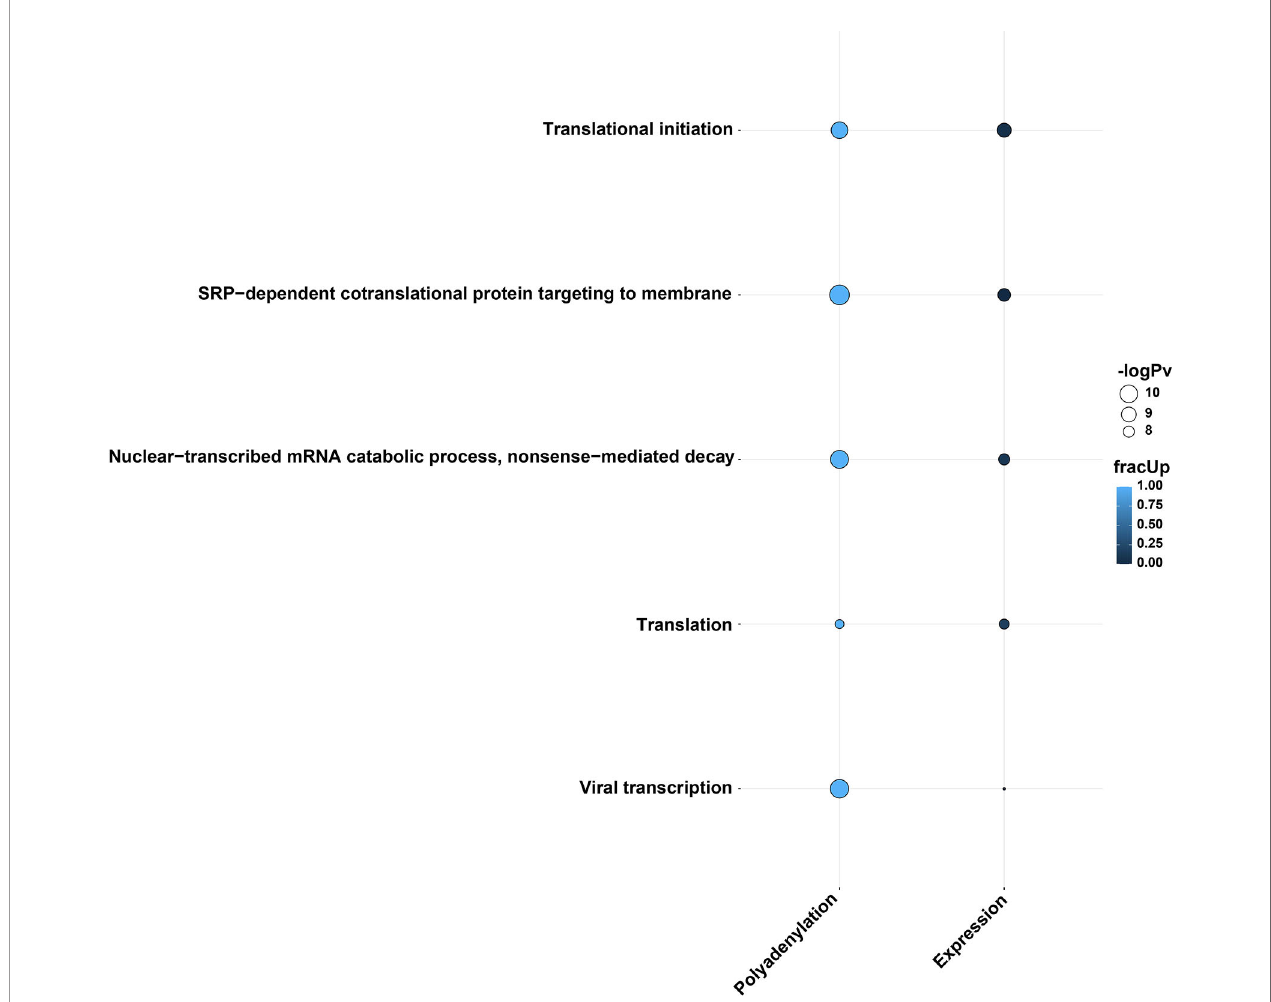
FIGURE 5 | Direction of differentially polyadenylated and expressed genes belonging to common GO biological terms in the two analysis methods using the Calu-3 48 hpi direct cDNA dataset. The plot shows a potential correlation in increased poly(A) tail length and downregulation in gene expression. This phenomenon may arise due to the virus-driven translation inhibition and host-driven post-transcriptional regulation. The bubble size and color indicate the -log10 enrichment p-values and fraction of upregulated genes/genes with increased polyadenylation, respectively. Thresholds of padj < 0.05, enrichment p-value < 0.0001 were used. Only bubbles which meet the thresholds are shown. Related to Figure S7 and Data S4